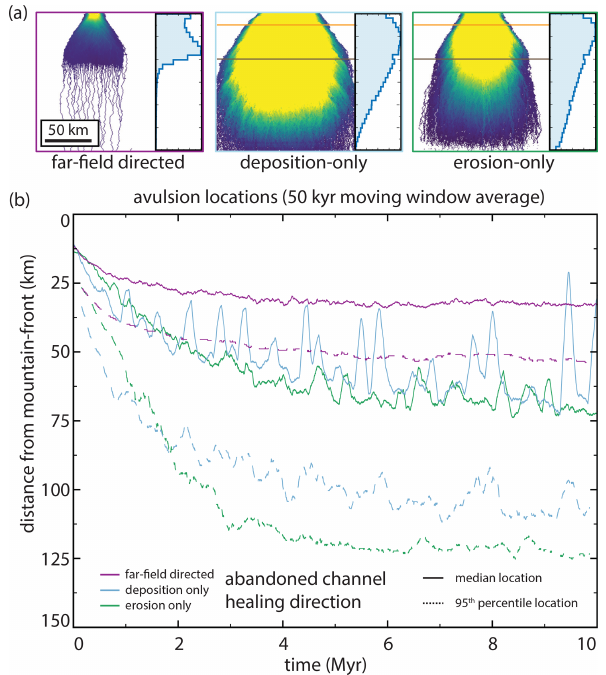
Figure 12. The effect of healing mode on (a) planform appearances and normalized avulsion location histograms and (b) characteristic avulsion locations through time. Runs are identical other than em- ploying different abandoned channel healing modes. Horizontal or- ange and dark brown lines show proximal and distal (respectively) distances from mountain fronts for Fig. 7b (deposition only) and Fig. 7c (erosion only). Color scale for inset planform appearances is the same as in Fig.